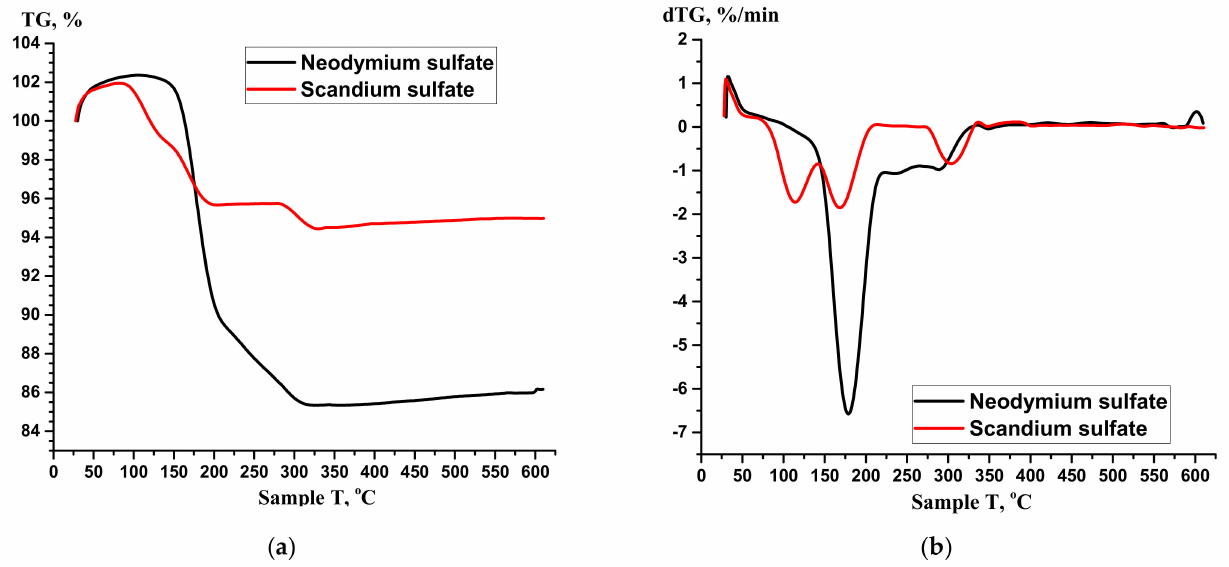
Figure 11. TGA curves of neodymium sulfate and scandium sulfate mass loss ( a ) and rate of mass loss ( b ). A comparison of thermal destruction curves (mass loss (a) and rate of mass loss (c)) of individual Amberlite IR120 (without sorbed Nd 3+ ions), Amberlite IR120 from ratio 6:0 (with Nd 3+ ions) and Amberlite IR120 (with Nd 3+ ions) from ratio 5:1 is presented in Figure 12. From the obtained data, it was seen that the mass loss of the three samples of Amberlite IR120 occurs almost simultaneously up to 150 ◦ C. Further mass loss occurs faster for Amberlite IR120 6:0 and Amberlite IR120 1:5 due to the fact of presence of neodymium ions in the macromolecular matrix, wherein the rate of mass loss for individual ion- exchanger is lower in comparison with Amberlite IR120 from the interpolymer pair due to a lesser amount of sorbed metal in the ion-exchange structure. Thermal decomposition of Amberlite IR120 occurs up to 400 ◦ C. The temperature area from 400 ◦ C to 625 ◦ C can be named as stabilization area with the indication of the process ending. The figure also presents a comparison of TGA curves (mass loss (b) and rate of mass loss (d)) of the following macromolecular structures: individual Amberlite IR120 (without sorbed Sc 3+ ions), Amberlite IR120 from ratio 6:0 (with Sc 3+ ions) and Amberlite IR120 (with Sc 3+ ions) from molar ratio 5:1. The obtained results show that the process of thermal destruction (particularly mass loss) occurs almost simultaneously until 200 ◦ C. The temperature area from 300 ◦ C to 450 ◦ C is the thermal destruction area for all of the samples. Further heating of these samples leads to a stabilization area, which indicates the end of the